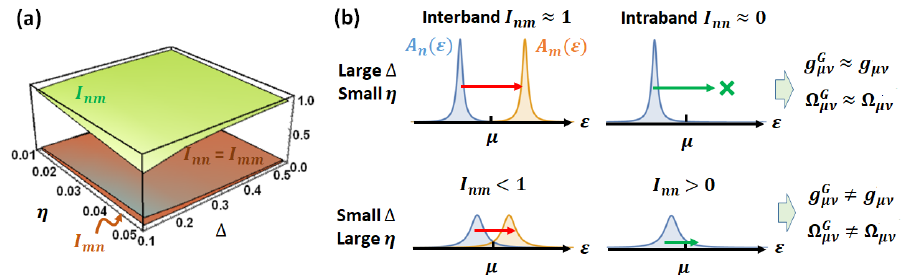
} that enter the expression of quantum , I , I , I nn nm mn mm